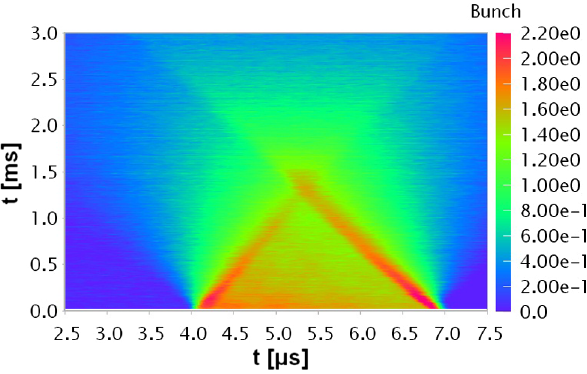
FIG. 32. Mountain view for a (cid:1) 50 (cid:1) A beam bunch signal.